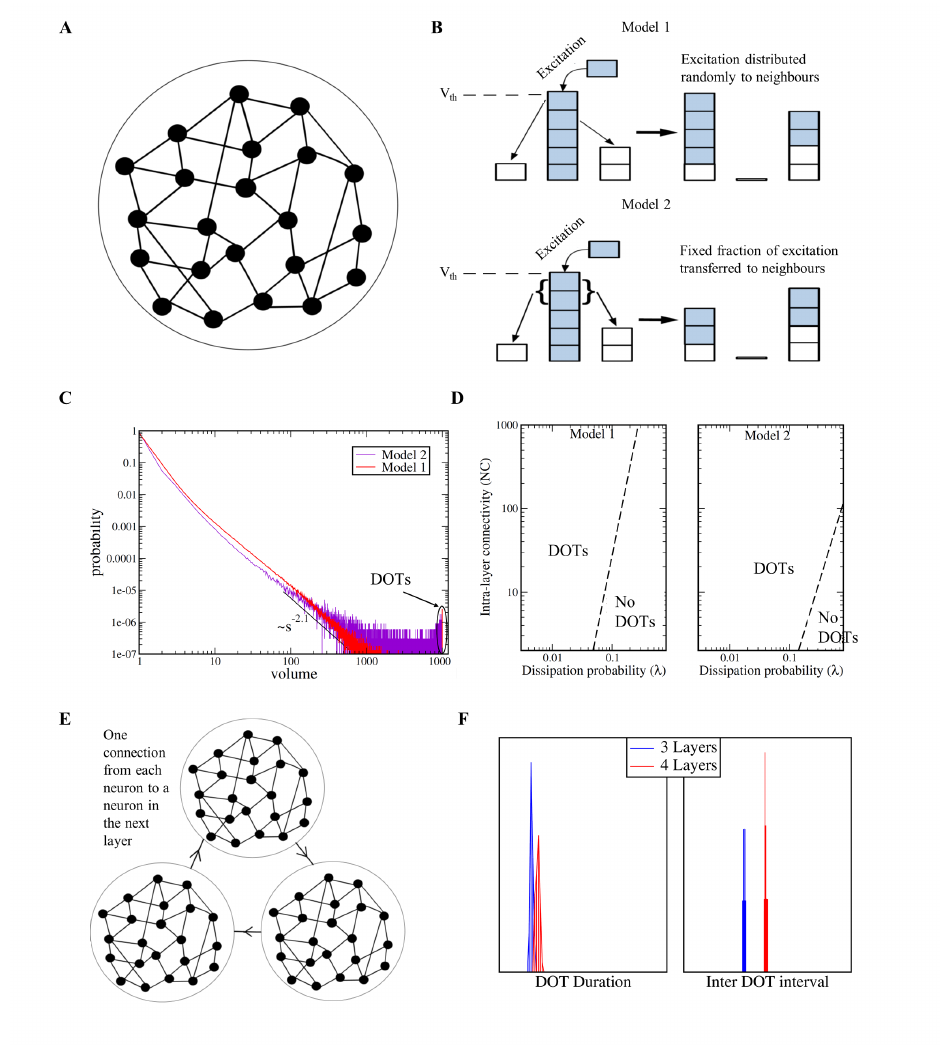
Fig. 7. Simulation setup and results. (A) Schematic diagram of the Single layer model of a network of N neurons with NC connections. (B) Schematic diagram of the mechanism of charge transfer in the two Models. (C) Distribution of avalanche volume for a network of N = 10,000 neurons in the two Models. (D) Phase diagram for the production of DOTs in terms of the dissipation and number of connections NC, for the two Models. The dashed line is indicative of the regime where DOTs disappear as one moves along either of the axis. (E) Schematic diagram of the multi-layer model. Each layer consists of N neurons with NC connections as before. However, now every neuron has one additional projection to the neurons in the next layer. (F) Distribution of DOT duration (defined in units of number of simultaneous DOTs in successive layers, which maps to number of DOTs times Δτ) and inter-DOT interval (defined in units of number of perturbations, i.e., simulation time steps) in a multilayer model with 3 layers (blue bars) as compared to one with 4 layers (red